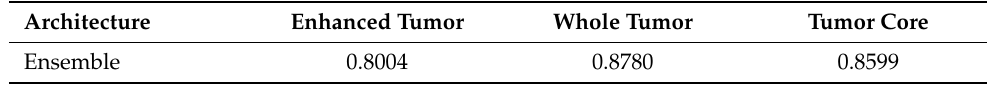
Table 12. Dice for Different Tumor Regions of the Ensemble